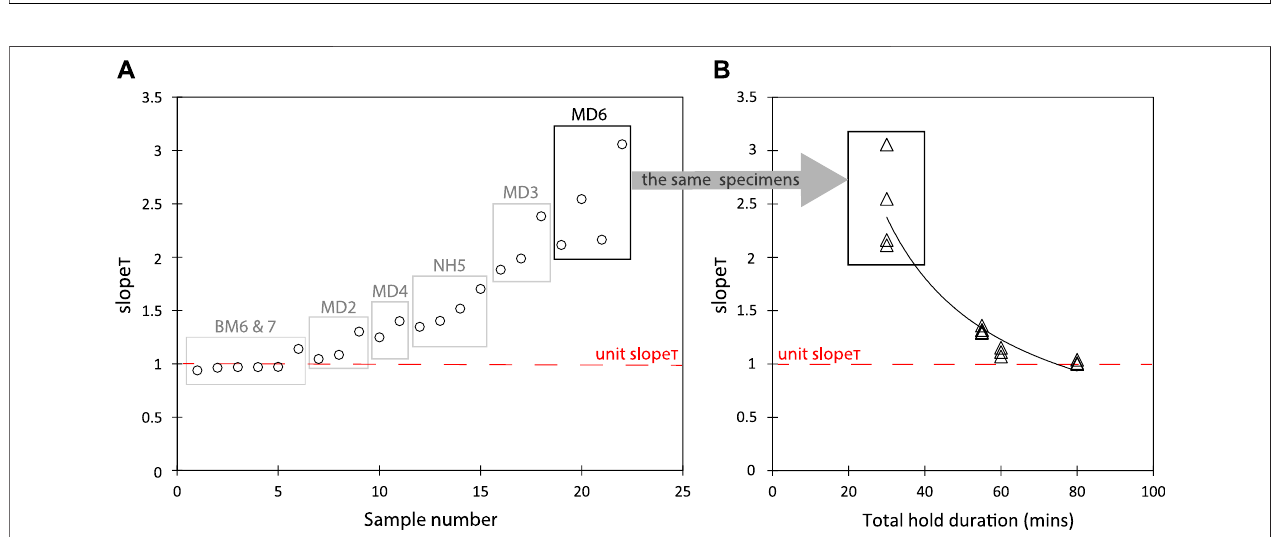
FIGURE 5 | Comparison of slope T results. (A) Results from a single Shaw-DHT experiment designed to test the effect of varying hold durations on palaeointensity estimates andslope T valuesusingholddurationsof15 minforTRM 1 andTRM 2 .Values areplottedbysiteinascendingorder. (B) Comparison ofslope T resultsfromsite MD6 asafunctionoftotalhold duration.Thehighslope T values(boxed) arethesamespecimensfromboxin Figure4A ;thesearecompared withsisterspecimensfrom other Shaw-DHT experiments which had longer total hold